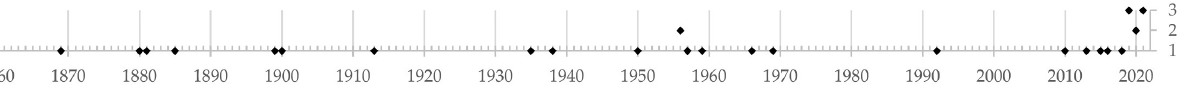
Figure 3. Timeline of Sowerby’s beaked whale ( Mesoplodon bidens ) observational records in the Skagerrak basin and adjacent waters.